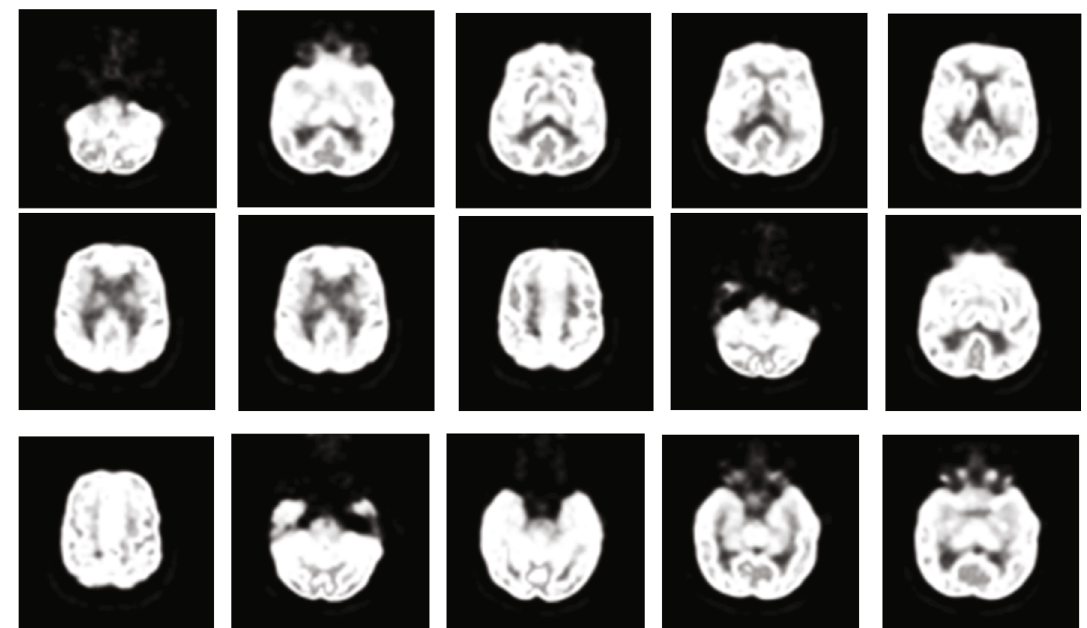
Figure 7: Sample PET images from the dataset.